Question: Summarize what this figure shows in one sentence.
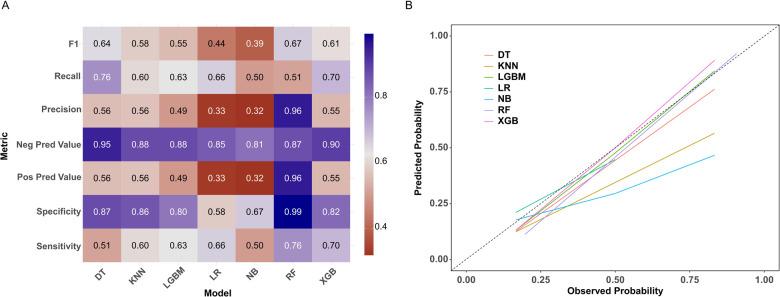
Answer: Comparative performance analysis of seven models in the external validation cohort. (A) Multi-metric performance summary of each model for HSA in the internal validation cohort; (B) Calibration characteristics analysis for each model in the external validation cohort. HSA, heat-sensitive angina; DT, Decision tree model; KNN, K-Nearest Neighbor model; LGBM, Light Gradient Boosting Machine model; LR, Logistic regression model; NBM, Naive Bayes model; RF, Random forest model; XGB, Extreme gradient boosting model.